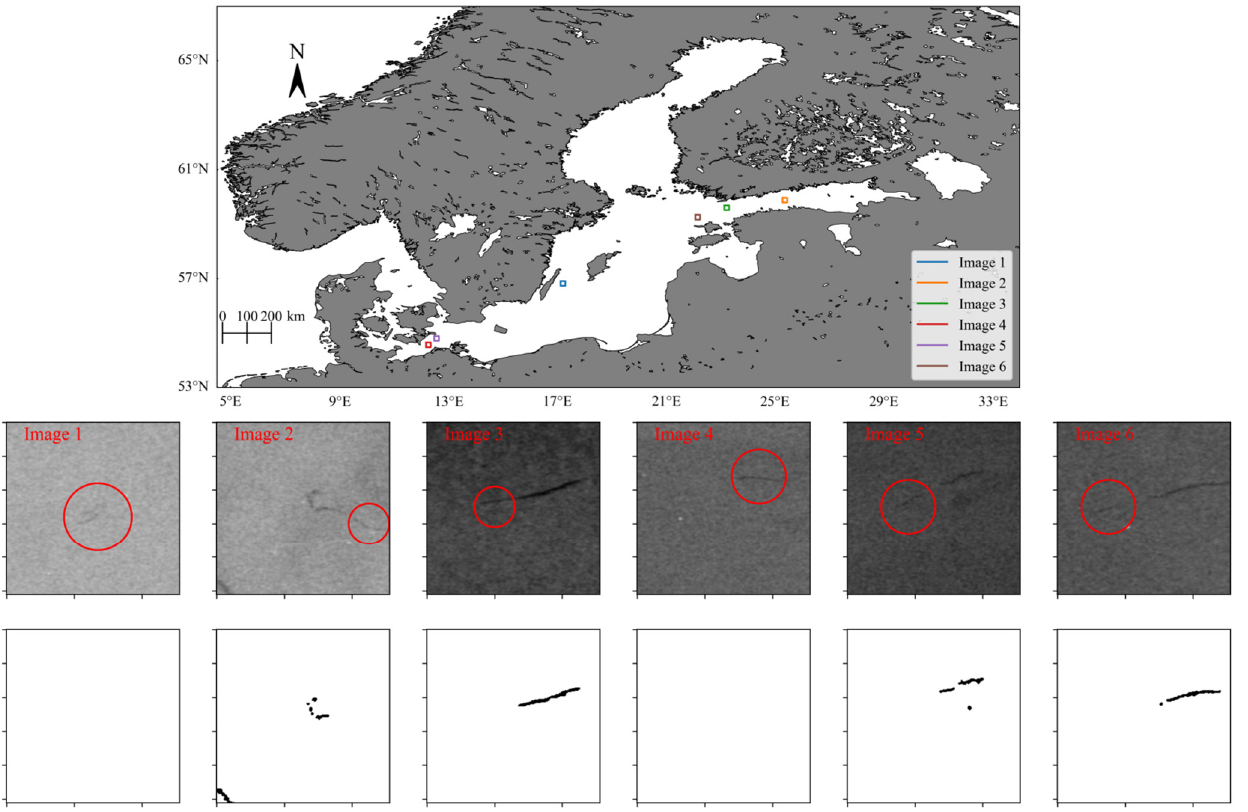
Figure 7. Oil patches that were missed. The top panel shows the locations of all images. The red circles in the input images indicate the oil patches that were not successfully segmented. Table 5. Ocean and atmospheric characteristics of the lookalikes in Figure 8.